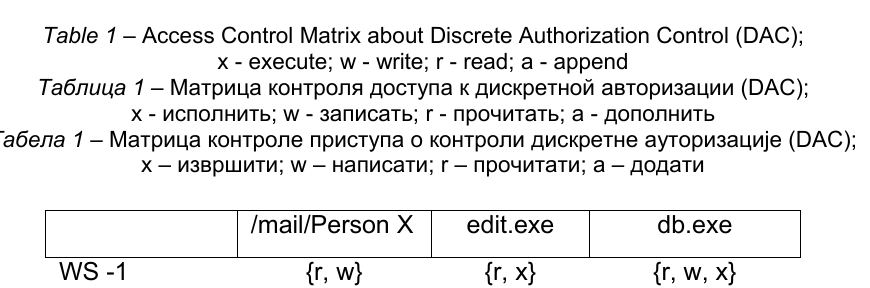
Table 1 – Access Control Matrix about Discrete Authorization Control (DAC); x - execute; w - write; r - read; a -